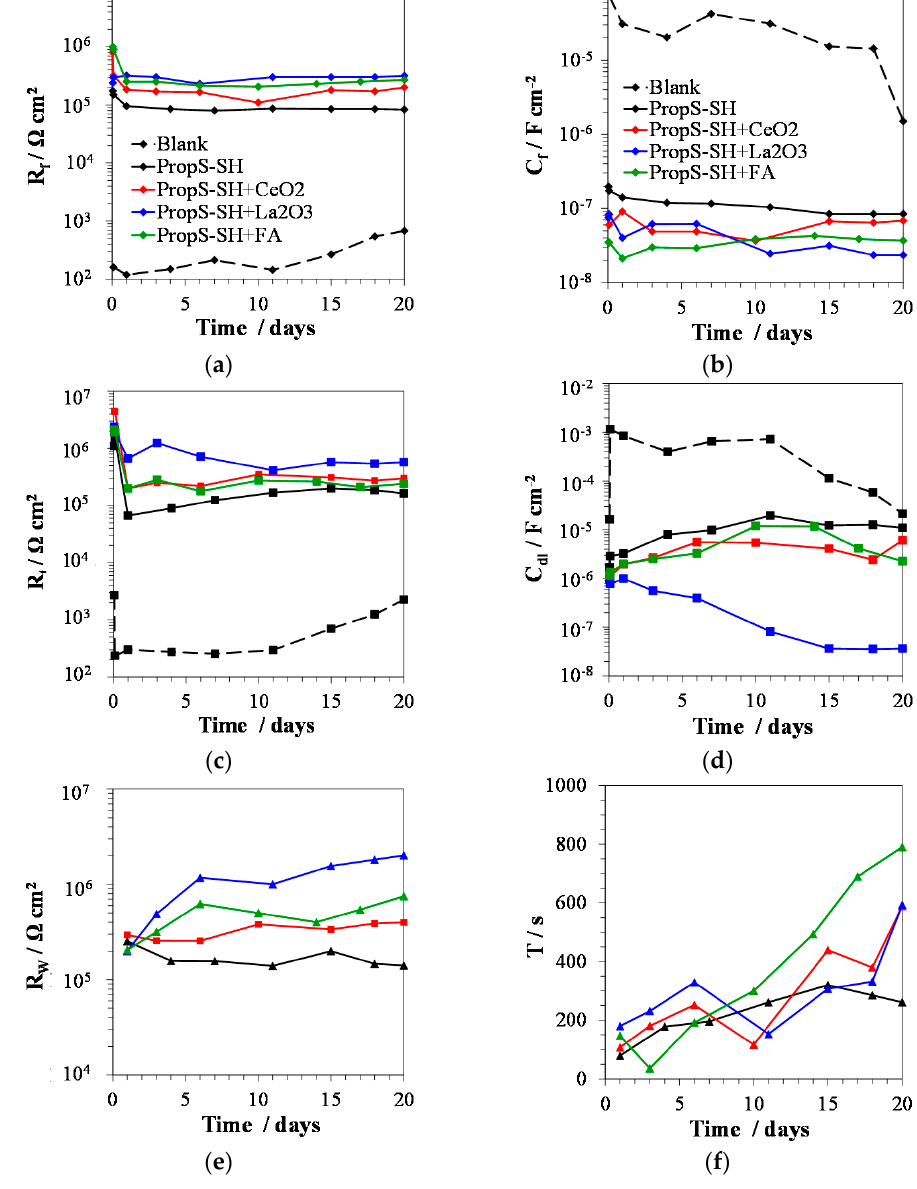
Figure 10. Evolution of the coating (or corrosion product film) resistance ( R f , a ) and capacitance ( C f , b ), charge transfer resistance ( R t , c ) and double layer capacitance ( C dl , d ), di ff usion resistance ( R W , e ), and di ff usion time constant ( T , f ), during immersion of bare and coated bronze in AR × 10 at 30 ◦ C. The coatings include PropS-SH and PropS-SH loaded with CeO 2 , La 2 O 3 , and